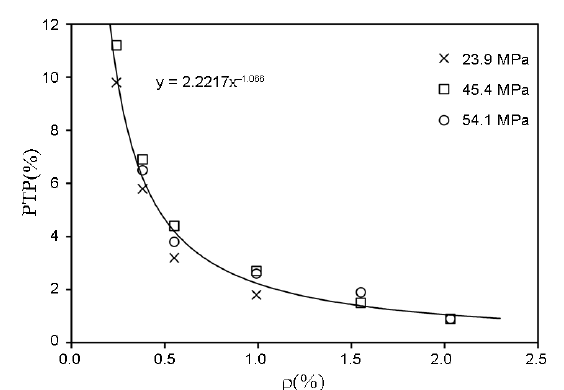
Fig. 9. Influence of reinforcement ratio on the